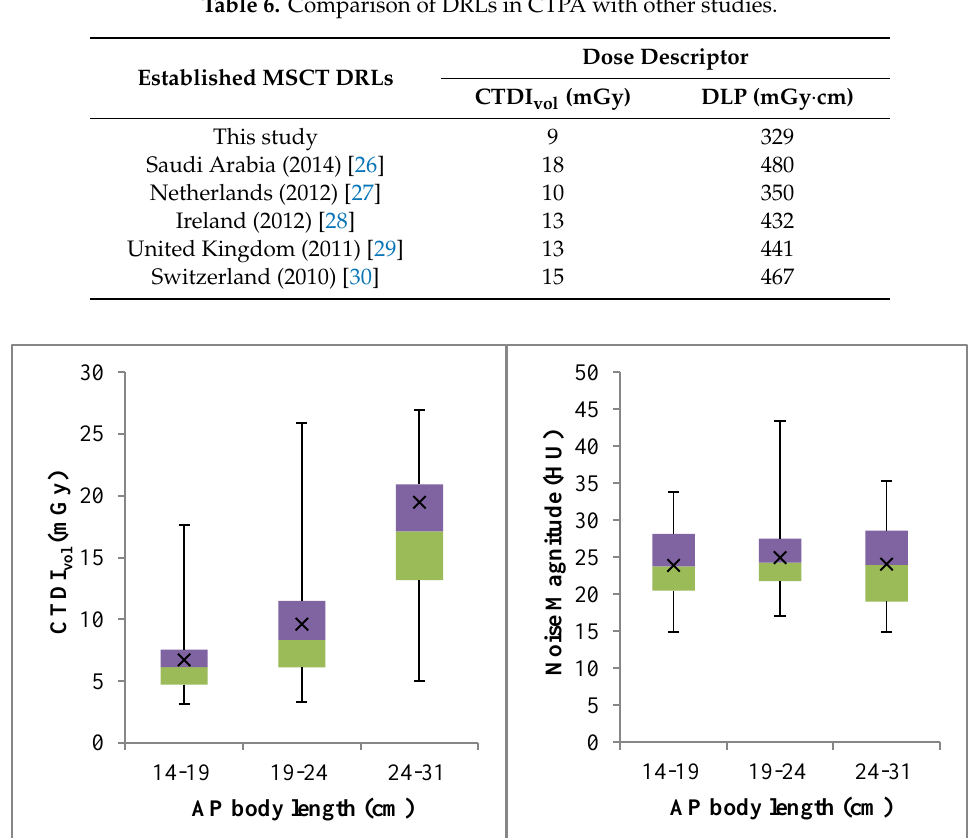
Figure 3. Comparison between the dose exposure and image quality performance in different patient AP body length groups.